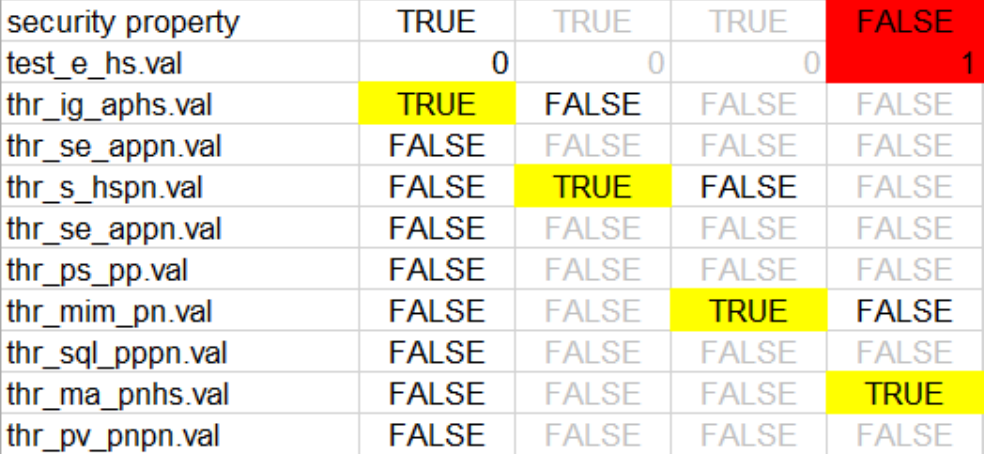
Figure 2. Cyber-attack scenarios implementation workflow. AADL: architecture analysis and design language, CE: counter example.